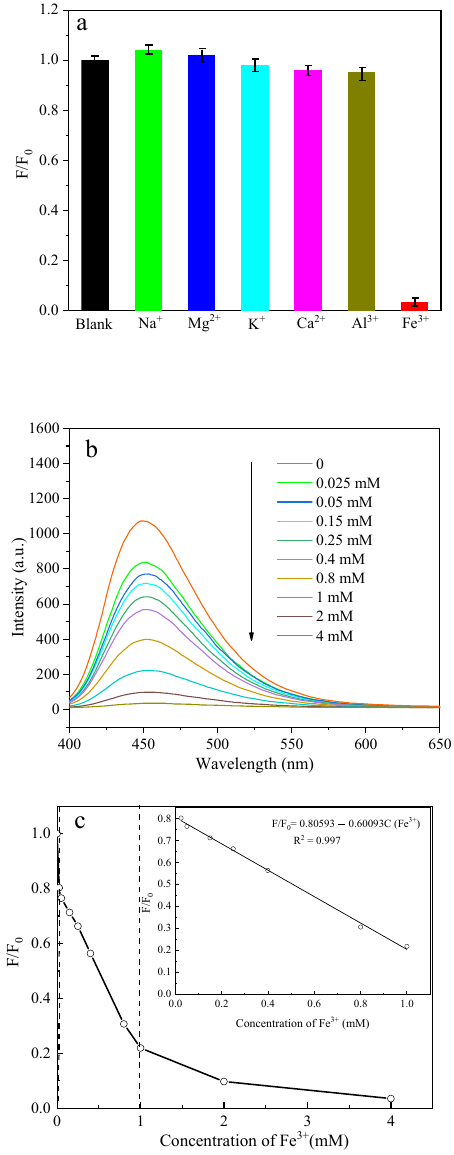
Figure 7. Change in PL intensity at 451 nm of poly 14 -N-CQDs in different metal ions ( a ); ion concentration-dependent PL intensity of poly 14 -N-CQDs in the presence of Fe 3+ ( b ); Stern–Volmer plot of the quenching of fluorescence in poly 14 -N-CQDs ( c ).